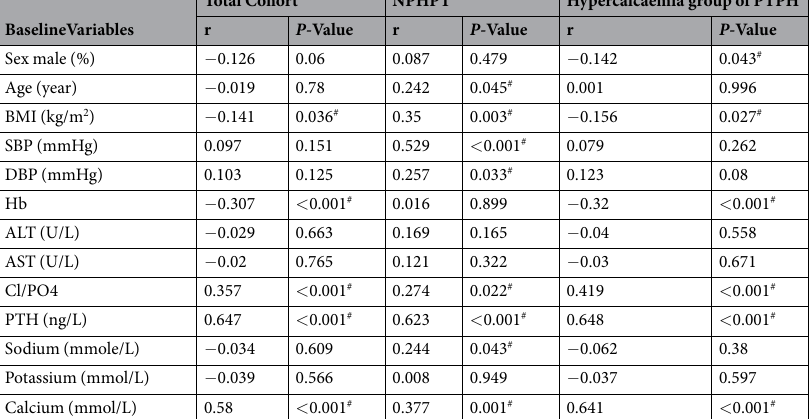
Table 3. Correlations of ALP with other variables in subjects with PHPT. PHPT, primary hyperparathyroidism; NPHPT, normocalcaemic primary hyperparathyroidism; BMI, body mass index; SBP, systolic blood pressure; DBP, diastolic blood pressure; Hb, Hemoglobin; ALT, alanine aminotransferase; AST, asparatate aminotransferase; Cl/PO4, Chloride/phosphorus ratio; PTH, parathyroid hormone; ALP, Alkalinephosphatase. # p < 0.05 vs . normal